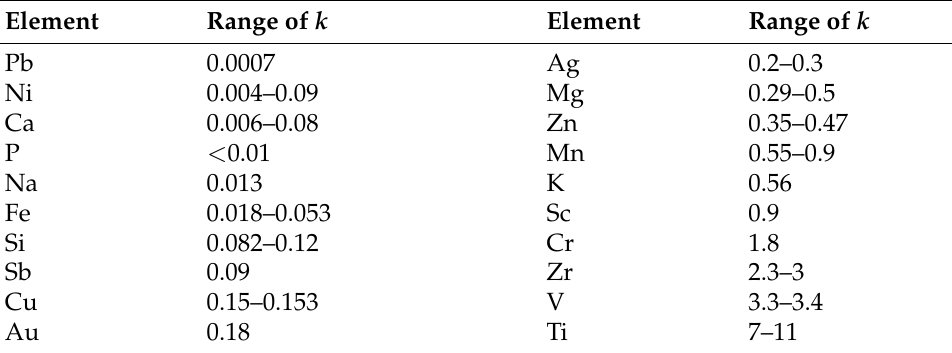
Table 6. The distribution coefficient ( k ) of main impurities in